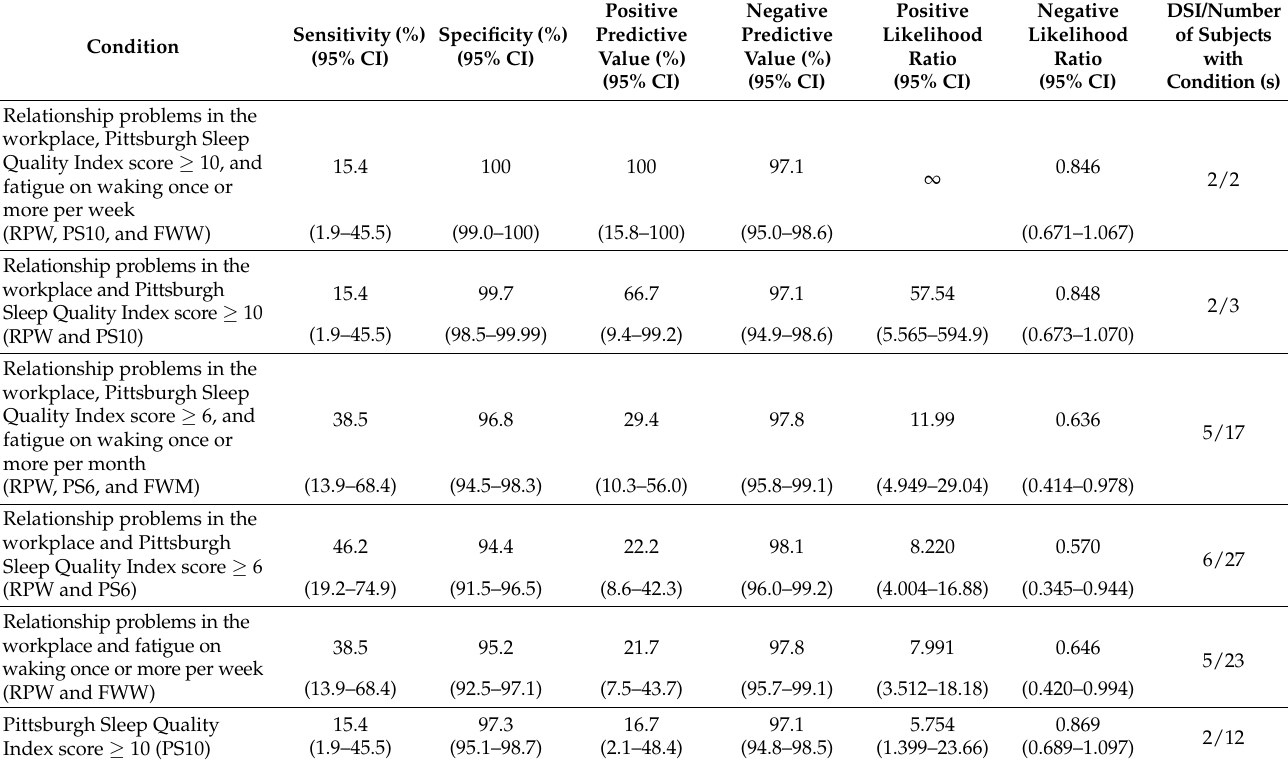
Table 2. Sensitivity, specificity, positive and negative predictive values, and likelihood ratios for depression with suicidal ideation (DSI) among primary care patients aged 35–64